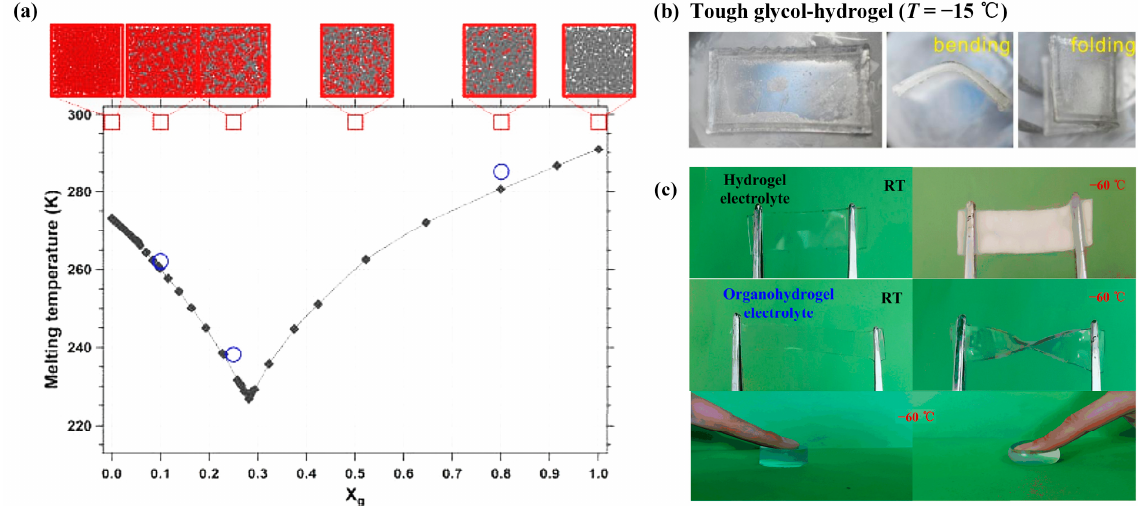
Figure 3. Effects of introducing organic solvents on the anti-freezing properties of hydrogels: ( a ) Melting temperature of aqueous glycerol changing with glycerol mol fraction; ( b ) Anti-freezing performance of cryoprotectant filled organohydrogels; ( c ) Images of hydrogels and organohydrogels electrolytes under low temperature. Reprinted with permission from [31,41,51].